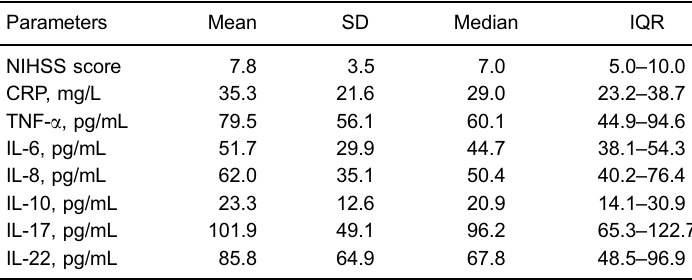
Table 2. Disease severity, C-reactive protein (CRP), and in fl ammatory cytokines of acute ischemic stroke